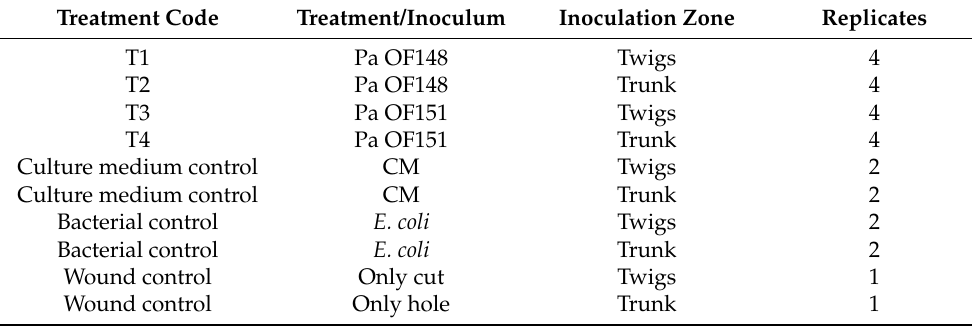
Table 1. Description of treatments for in-planta pathogenicity